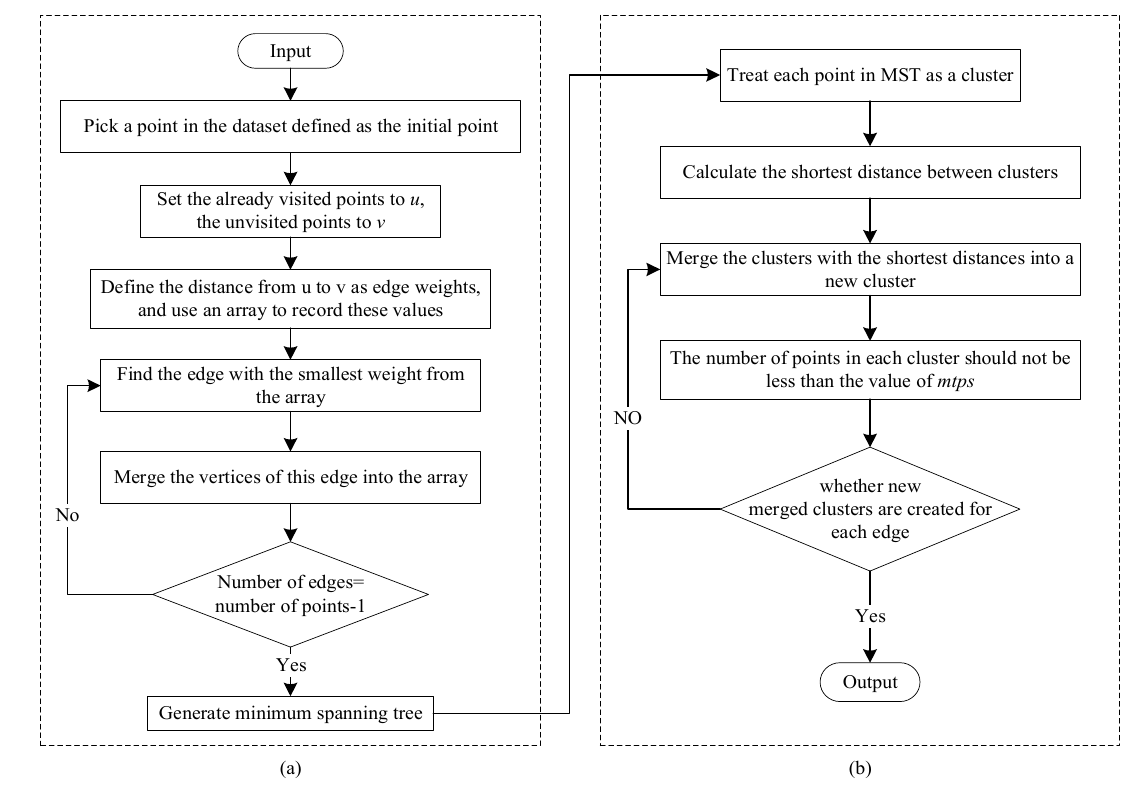
Figure 4. MST: ( a ) Prim algorithm; ( b ) Hierarchical clustering.